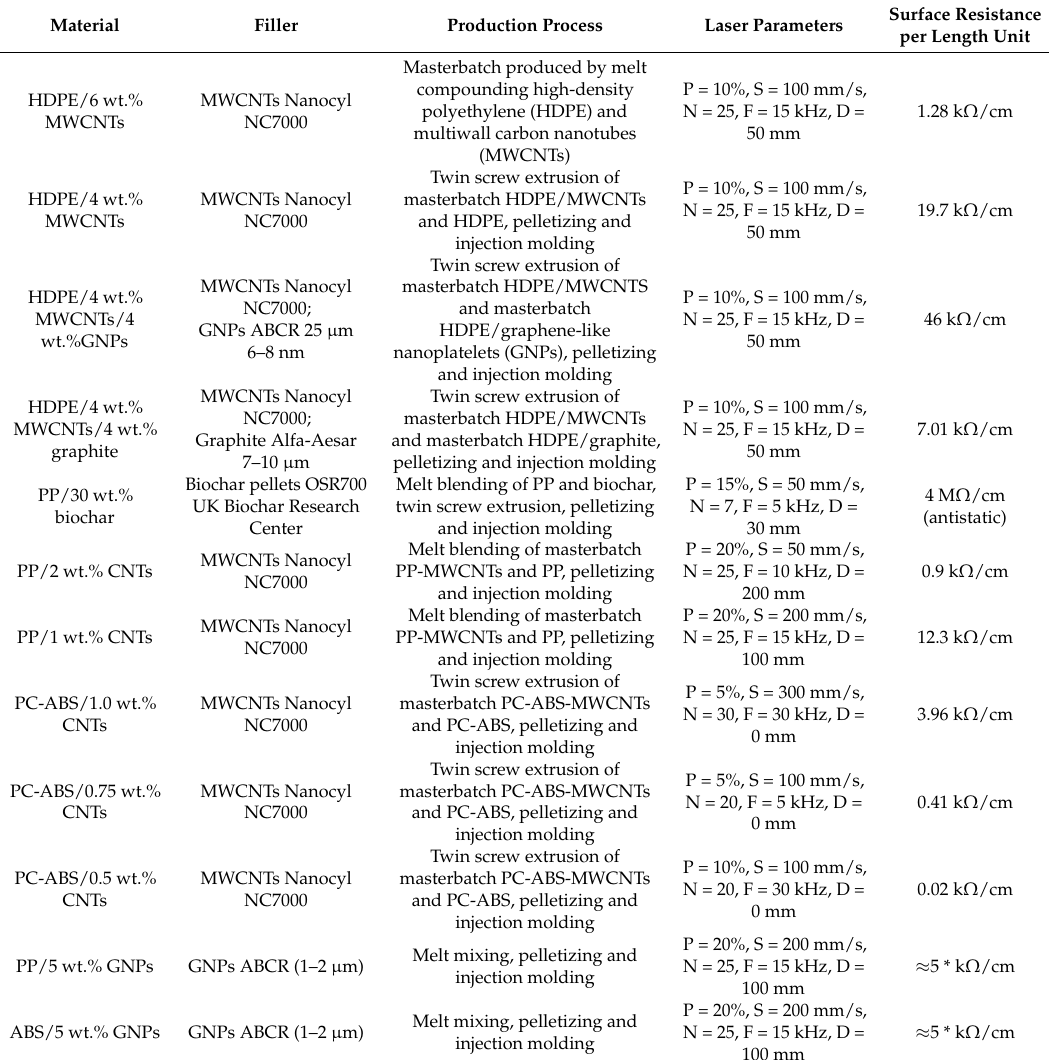
Table 1. Surface resistance per length unit measured for the laser tracks obtained under optimized conditions (P = power; S = scan rate; N = number of repetitions; F = frequency; D = defocus) on several polymer–carbon filler systems (* not good